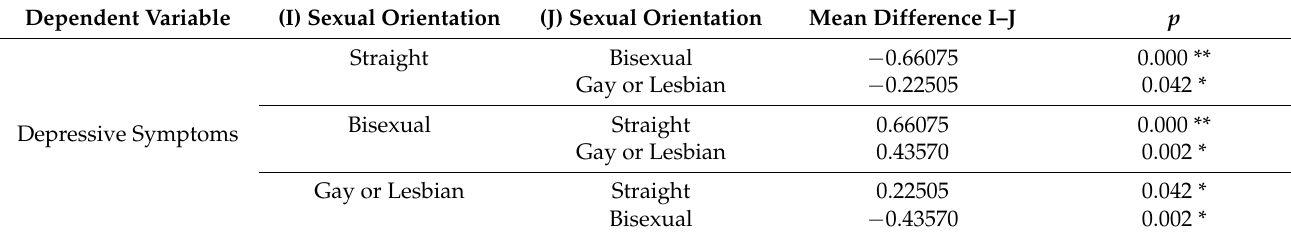
Table 3. Results for Depressive Symptoms by comparison groups (Sexual Orientation).